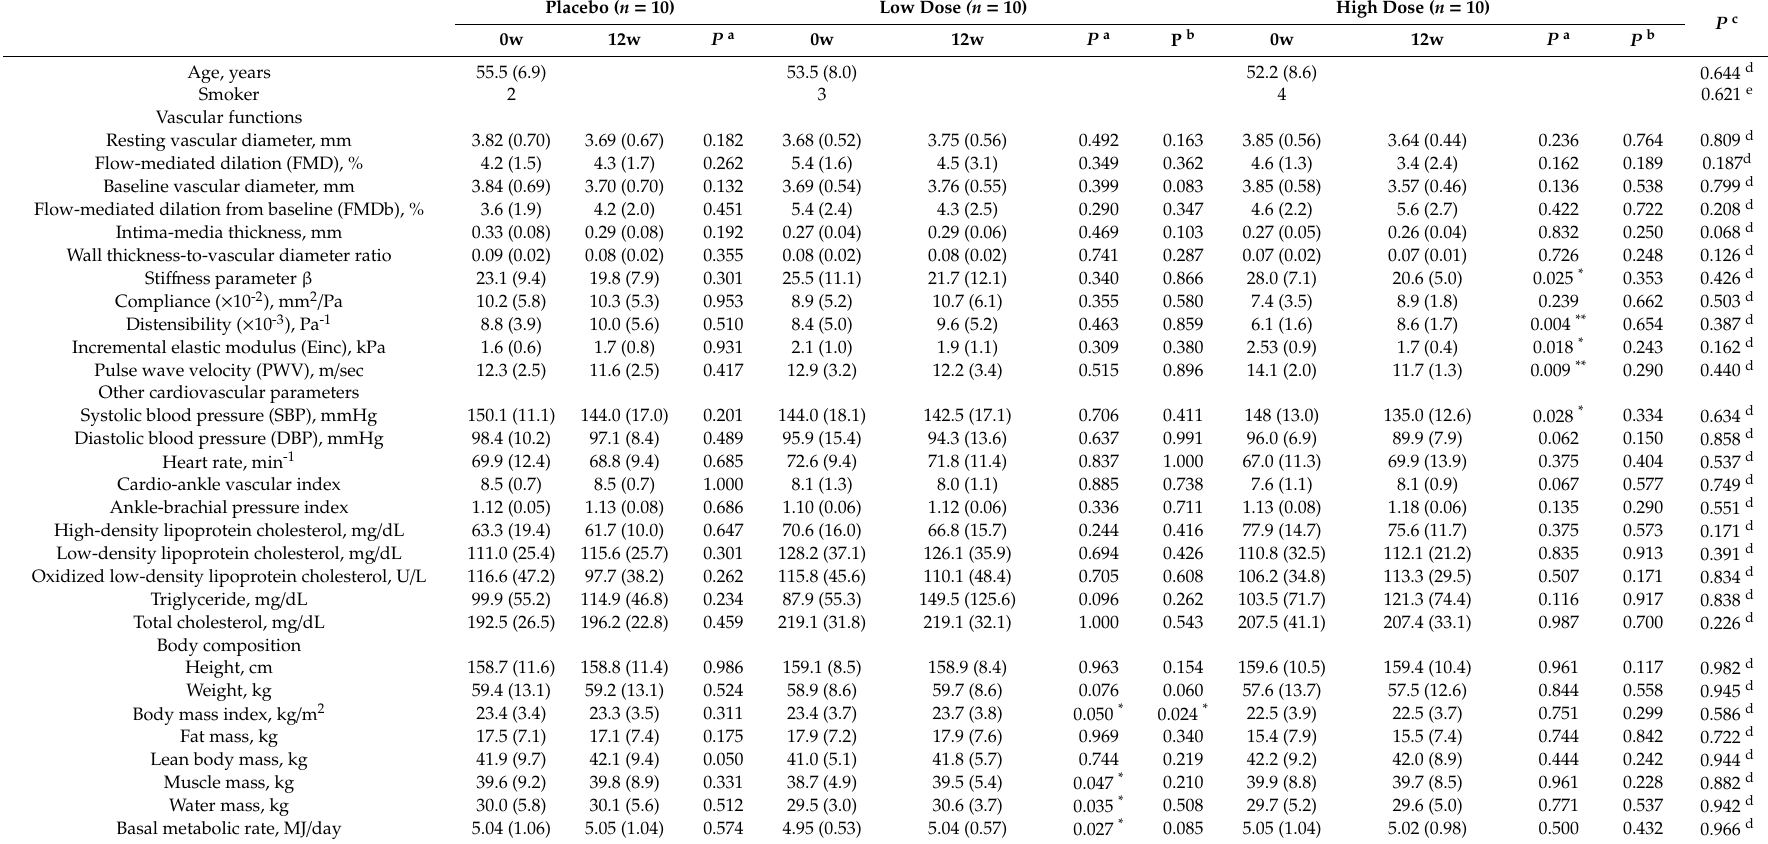
Values are mean (standard deviation) or the number of appropriate participants. a Baseline vs. after 12 weeks of intervention, paired t-test. b Change in placebo vs. low- and high-dose after 12 weeks of intervention, unpaired t-test. c Baseline di ff erences among the three groups. d One-way analysis of variance. e Chi-square test. * P < 0.05, ** P < 0.01 vs. before the intervention or change in